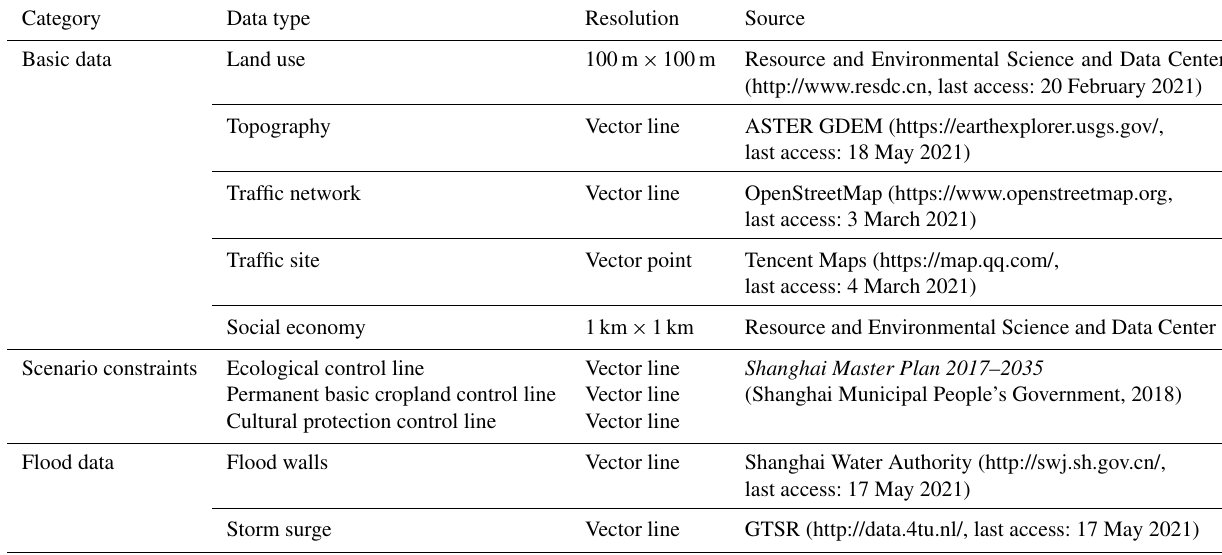
Table 1. Data required and sources. The list details the resolution and sources of the data in the study.